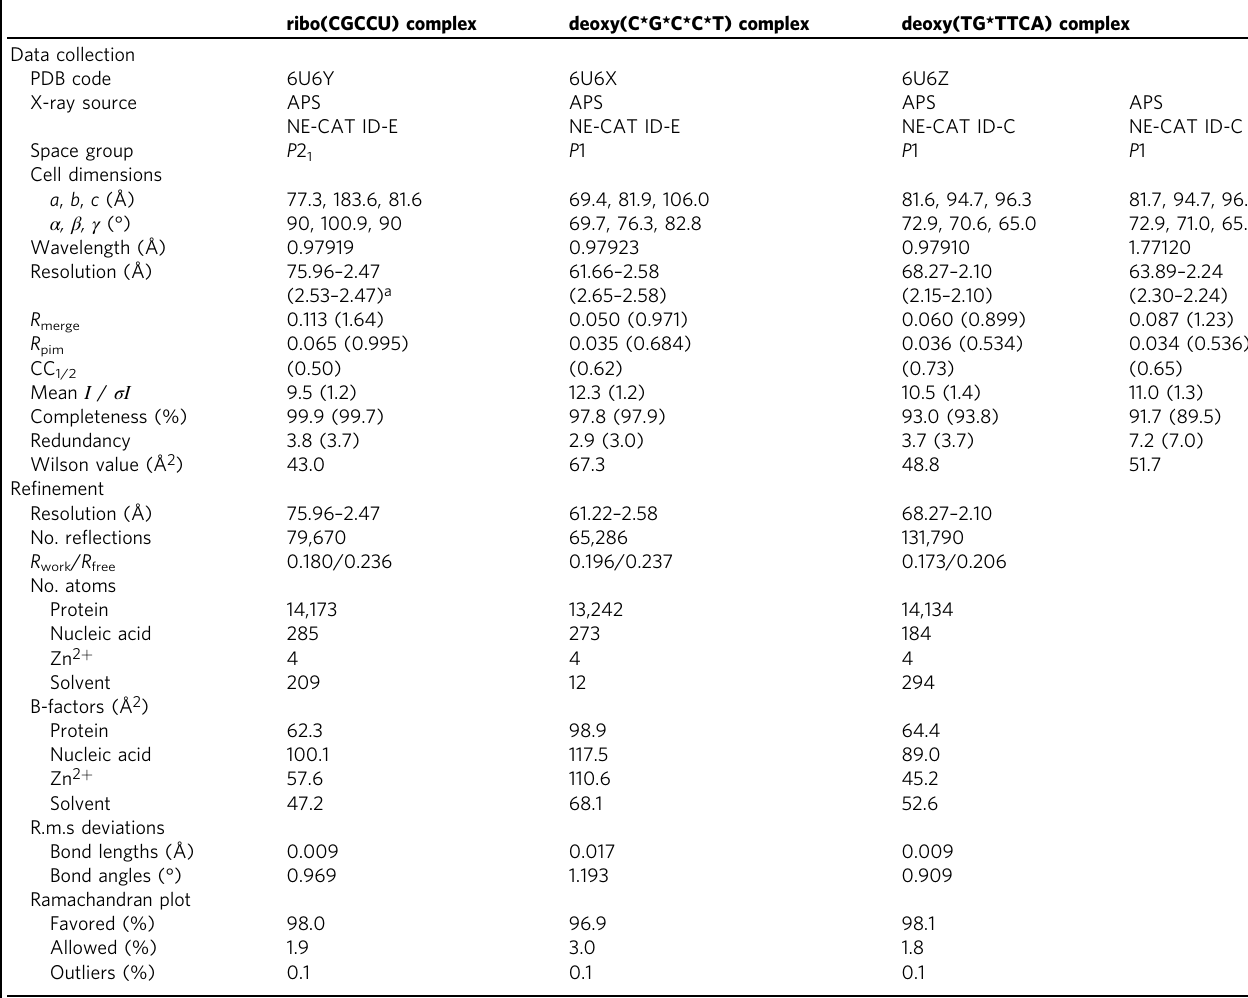
Table 1 Data collection and re fi nement